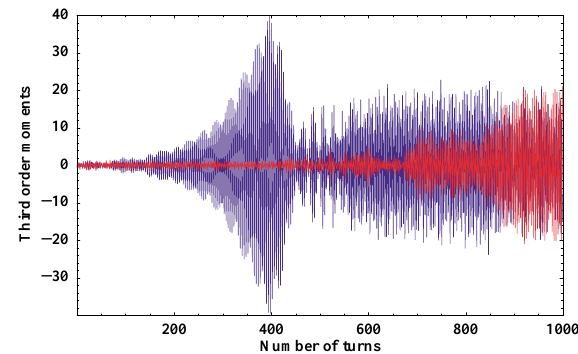
FIG. 13. (Color) Time evolution of (cid:5) x 3 (cid:6) (blue) and (cid:5) y 3 (cid:6) (red) for (cid:1) n x , n y (cid:2) (cid:1) (cid:1) 5.82, 5.86 (cid:2) in normalized units.